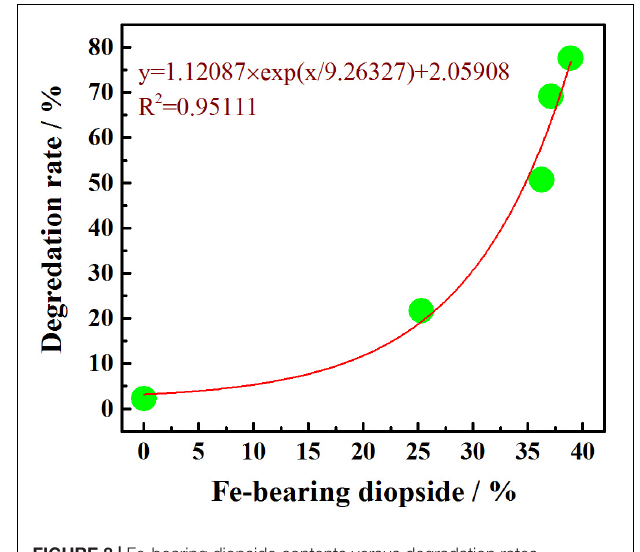
FIGURE 7 | Degradation rates of EBFS ceramics against RhB at pH = 2.